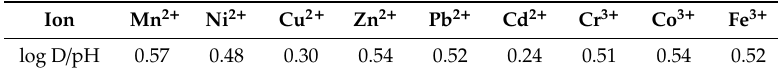
Figure 12. log D values of the P (AA / Kry23-DM) SAP at di ff erent pHs. Table 7. Distribution coe ffi cient (log D) / pH ratios of the heavy metal ions on P (AA / Kry23-DM) SAP (at pH > 3).